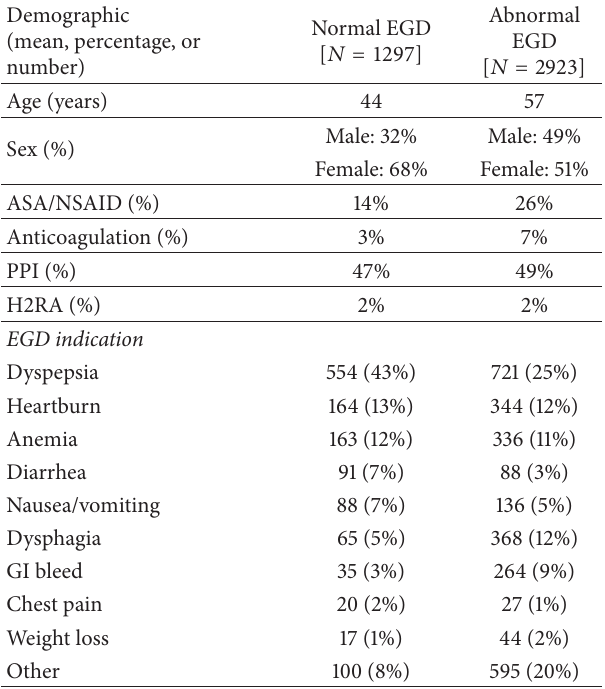
Table 1: Patient demographics and indication for EGD for patients with macroscopically normal and abnormal EGDs.